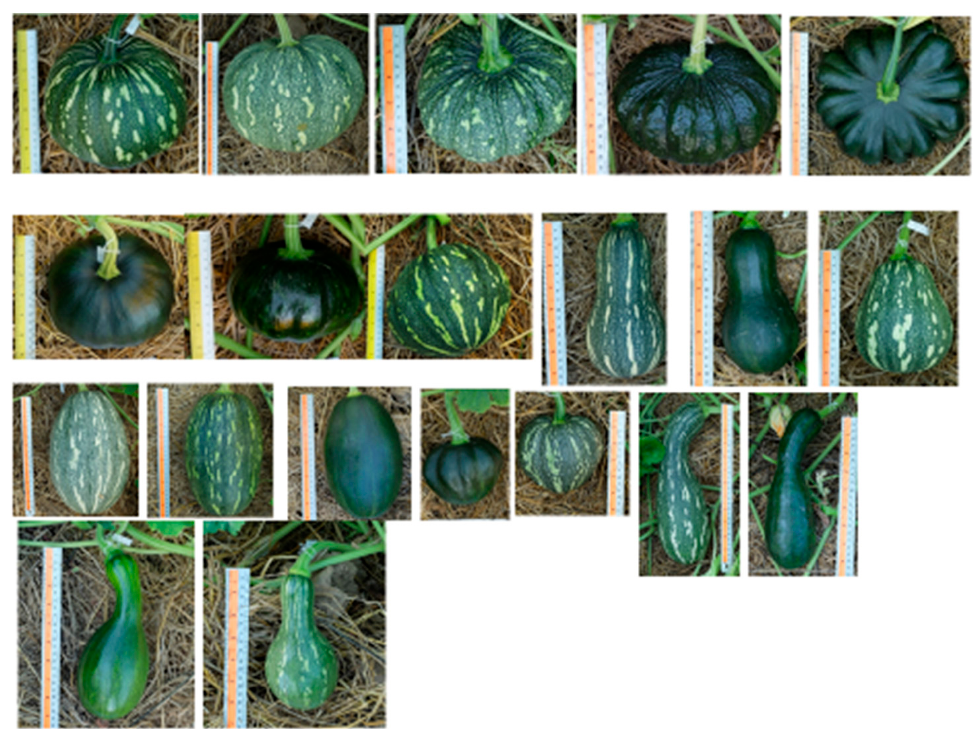
Figure 2. Fruit color and shape variability among pumpkin breeding lines developed at WorldVeg. 5. Loofah Sponge gourd ( Luffa cylindrica ; syn. L. aegyptiaca ) and ridge gourd ( L. acutangula ) are two